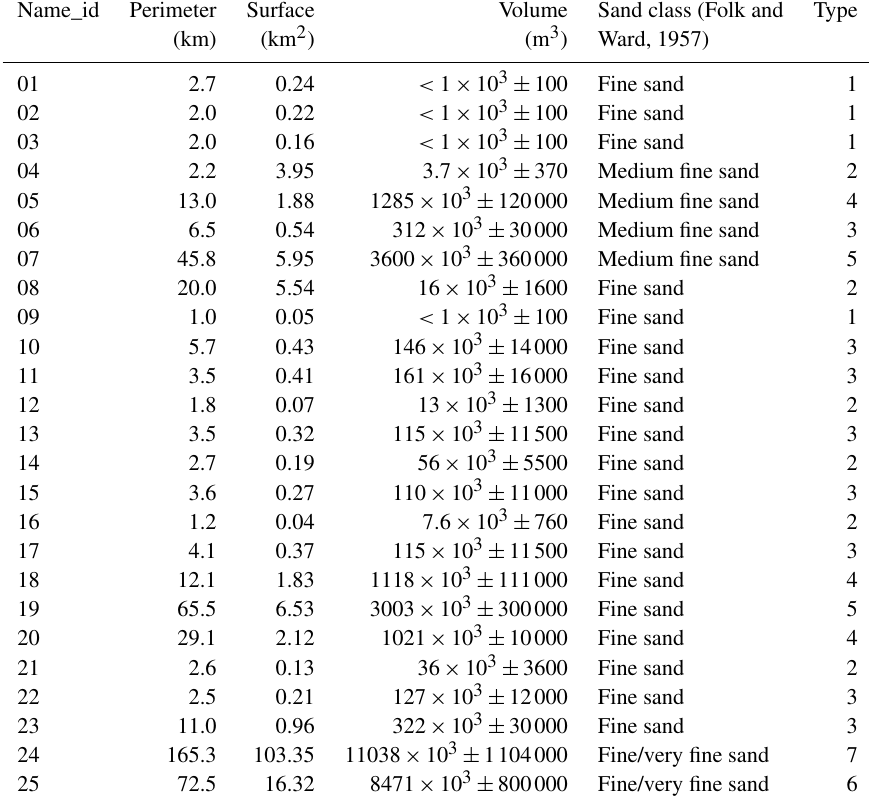
Table 1. Submerged sand deposit